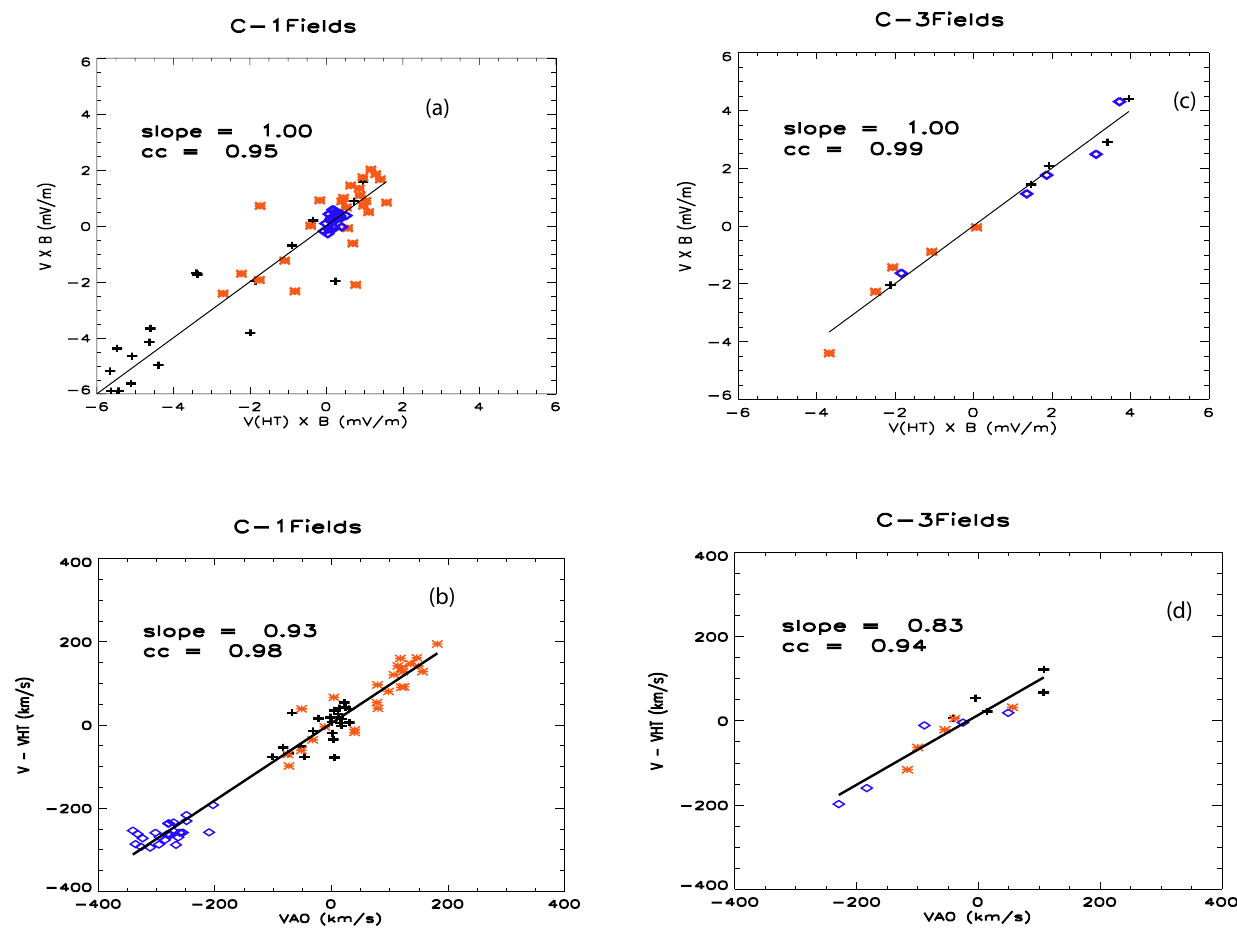
Fig. 9. The Wal´en relation test results for both types of magnetopause crossings. The two intervals (C1: 01:34:30–01:36:00 UT and C3: 02:55:30–02:55:50 UT) are randomly chosen with the left two panels showing the result for the first type and the right two panels showing the result for the second type. For each type, the top panel is the result of finding the deHoffmann Teller (HT) frame and the bottom panel shows the fitting result of the measured velocity in the HT frame versus the Alfv´en